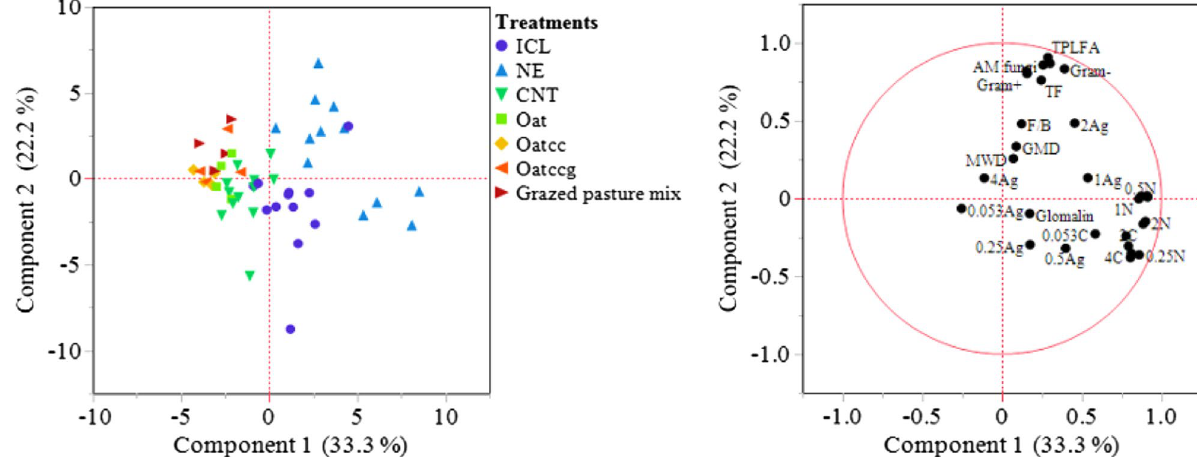
Figure 4. Principal component analysis (PCA) of the soil parameters with scores plotted in the plane of PC1 and PC2 (left) and eigenvectors (right). ICL integrated crop–livestock, NE natural ecosystem, CNT control, CC cover crop, g grazing, TPLFA total phospholipid fatty acid, AM fungi arbuscular mycorrhizal fungi, TF total fungi, F/B fungi/bacteria ratio, MWD mean weight diameter, GMD geometric mean diameter, Ag aggregate size, C carbon, N